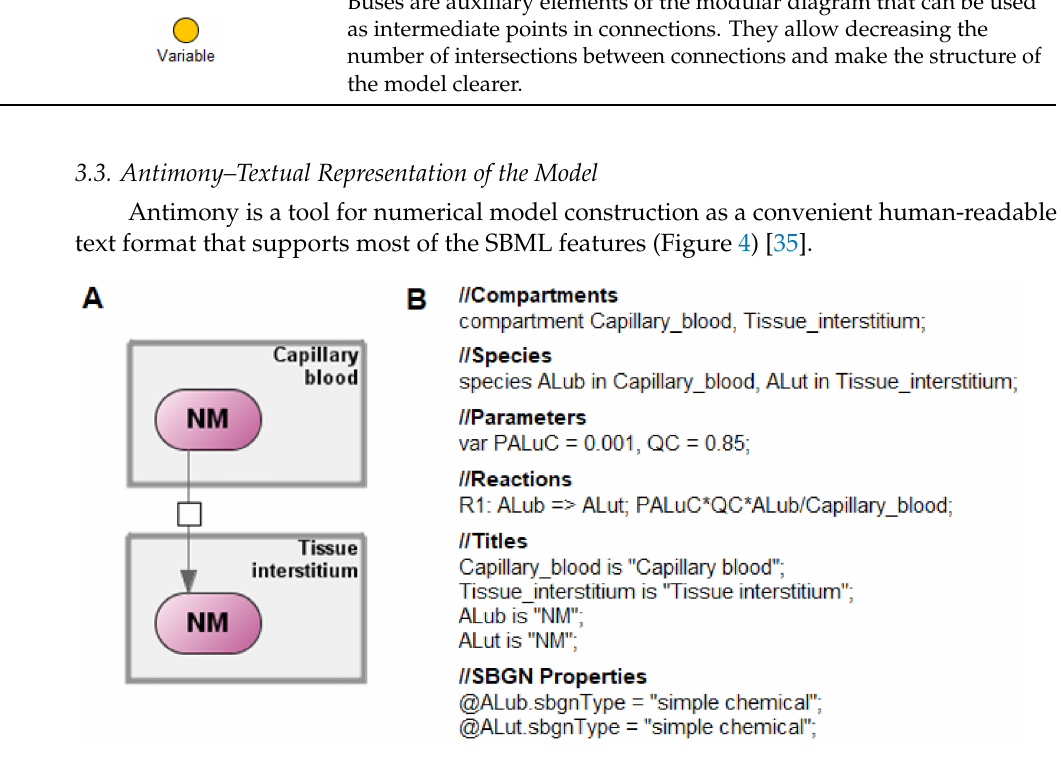
Figure 4. An example of the simple model with one reaction of nanomaterial (NM) transport from capillary blood to tissue interstitium. ( A ). Visual representation of the model in SBGN. ( B ). The corresponding Antimony code which includes the definition of compartments ( Capillary_blood and Tissue_interstitium ), species (amounts of nanomaterial in capillary blood, Alub , and in tissue interstitium, Alut ), parameters ( PALuC and QC ), reactions ( R1 ) with the related kinetic laws (a math equation to the right of the reaction declaration), and properties for the visual model representation, including titles of the model elements, and specification of the SBGN